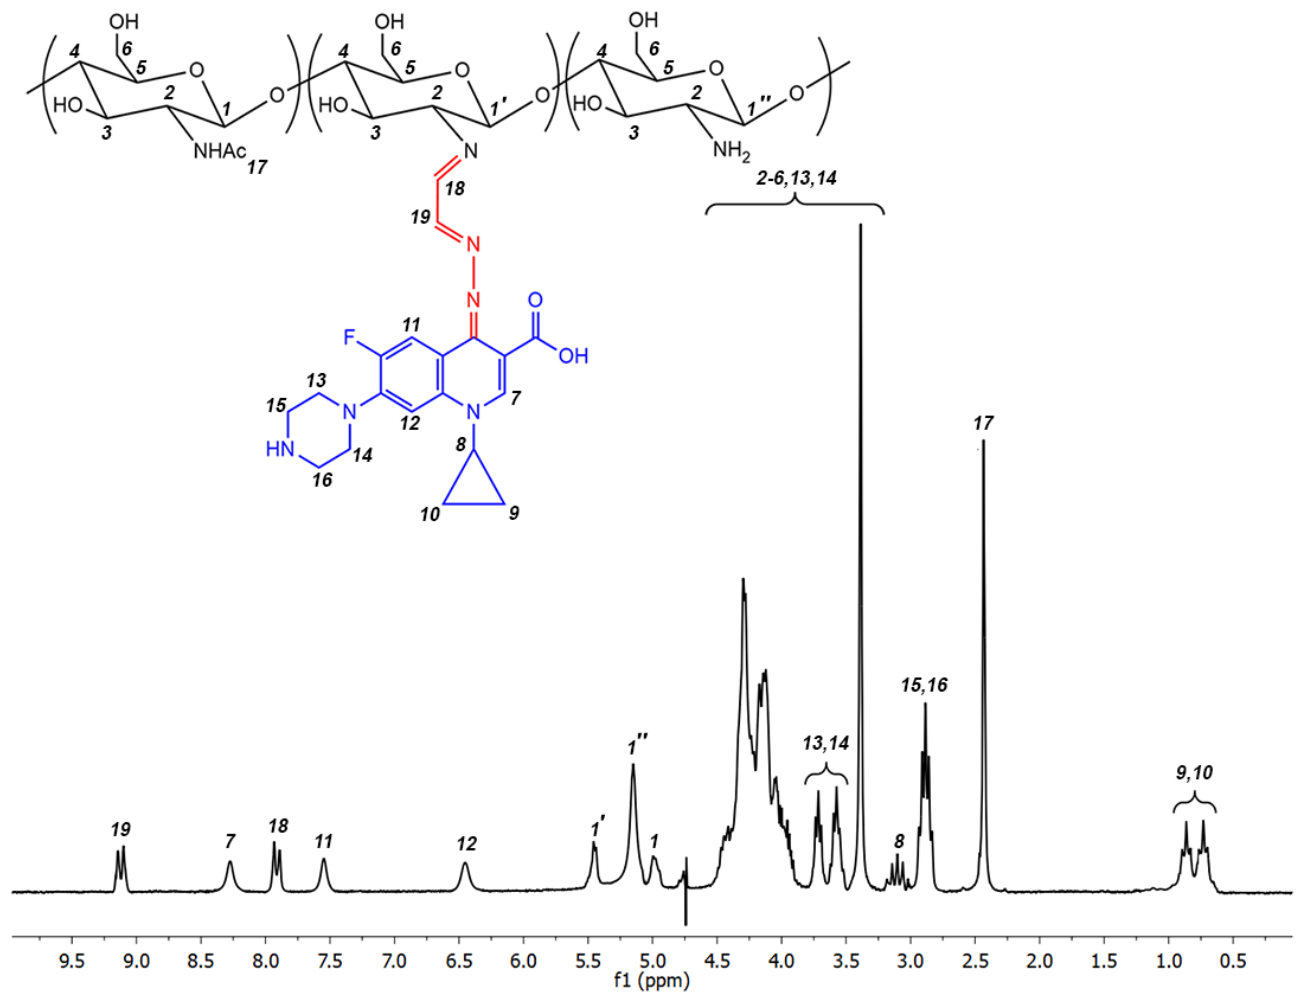
Figure 3. 1 H NMR spectrum of C-SP-CS-III-M. Table 6. Characteristics of the nanoparticles prepared by ionic gelation